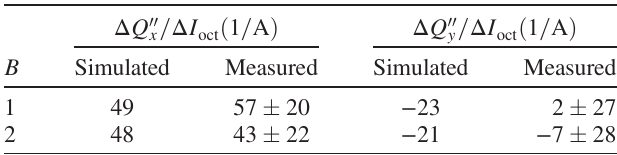
TABLE III. MAD - X calculations vs measurements of second order chromaticity introduced by the Landau octupoles per current for the two LHC beams ( B ).